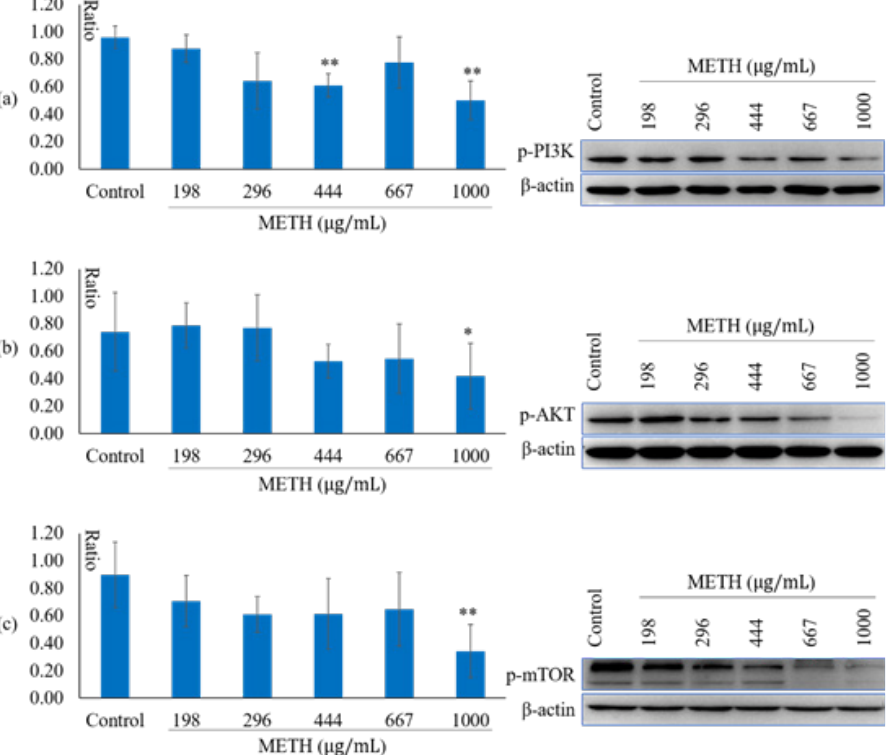
Figure 5: METH inhibited the activity of PI3K-Akt-mTOR signaling pathway. (a) the expression of p-PI3K; (b) the expression of p-Akt; (3) the expression of p-mTOR. The annotation * indicates a p value < 0.05 versus control group. The annotation ** indicates a p value < 0.01 versus control